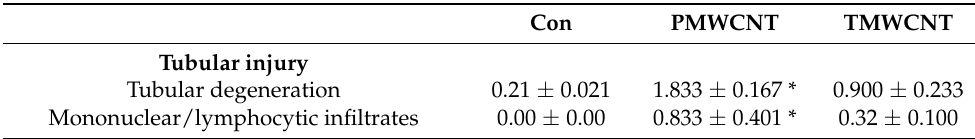
Figure 6. The effects of administering multi-walled carbon nanotubes (MWCNTs) on the morphology of mouse kidneys after one year. ( A ) Hematoxylin and eosin-stained images show the morphologies of mouse kidneys treated with saline, PMWCNTs, and TMWCNTs. ( B ) PMWCNTs induce hydronephrosis after one year. Inset shows traces of the glomerulus. ( C ) Paraffin-embedded kidney tissue sections one year after the administration of PMWCNTs and TMWCNTs were stained with H&E and Masson’s trichrome. Red arrow indicates tubular epithelial vacuolation. Empty arrow indicates tubular epithelial necrosis. Arrow head indicates tubular dilation. Empty arrow head indicates lymphocyte infiltration. Dashed arrow and dashed empty arrow indicate tubulointerstitial fibrosis and glomerulosclerosis, respectively. Magnification and scale bar are indicated in each figure. Table 2. Summary of pathological observations indicative of PMWCNT- and TMWCNT-induced renal dysfunction.